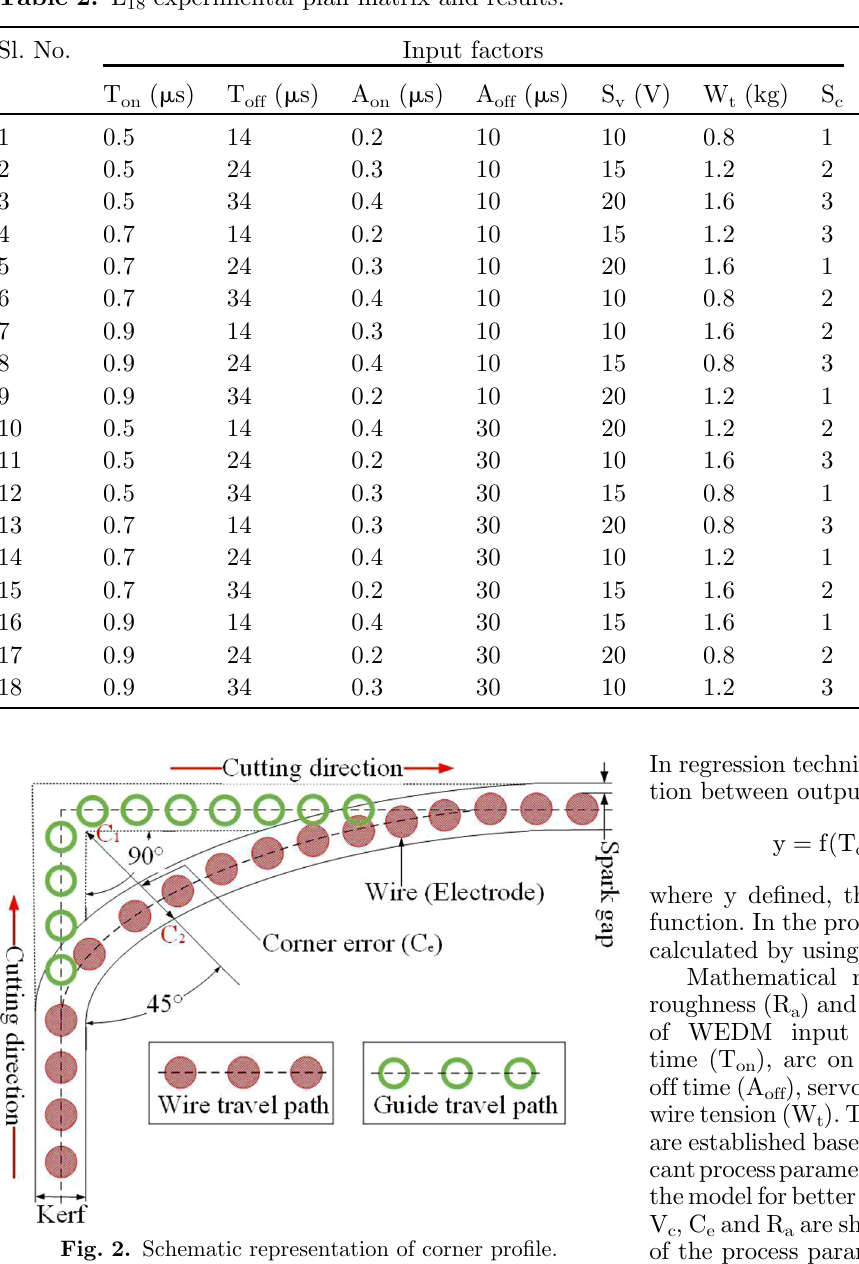
Table 2. L experimental plan matrix and results. 18